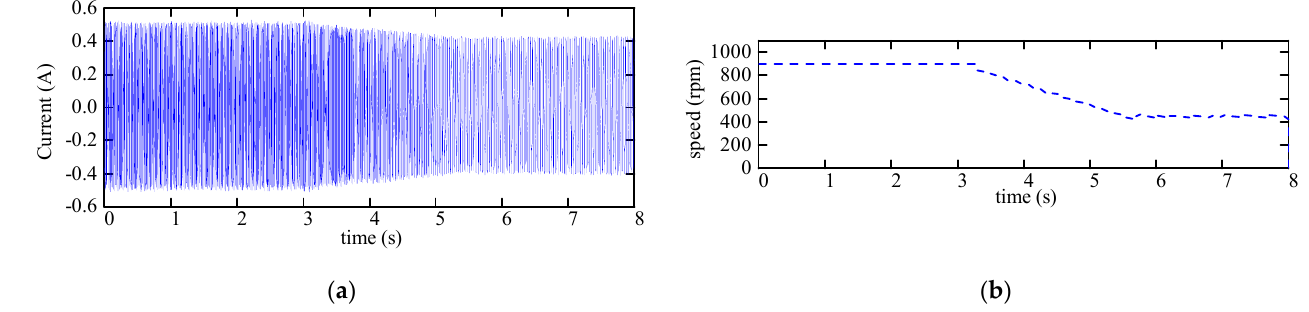
Figure 9. Experimental waveforms of current i a and speed for partially − demagnetized PMSM under nonstationary conditions. ( a ) Current waveform of i a ; ( b ) speed waveform.